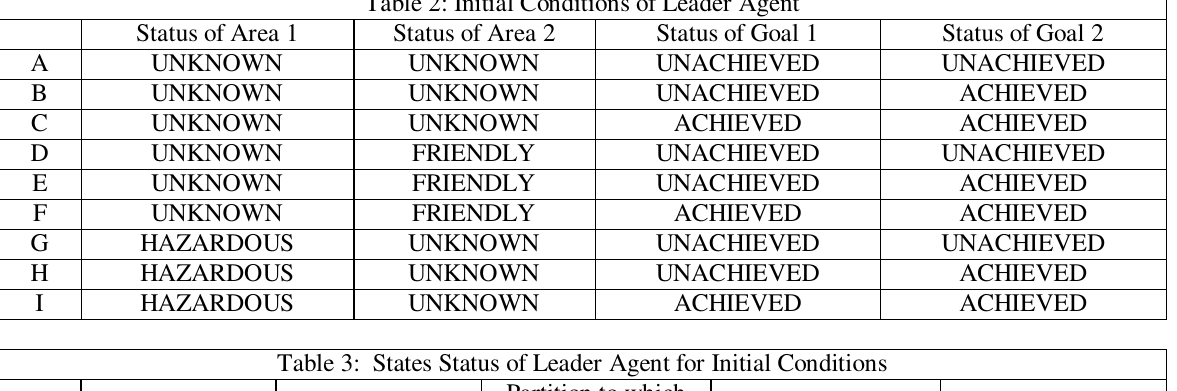
Table 3: States Status of Leader Agent for Initial Conditions